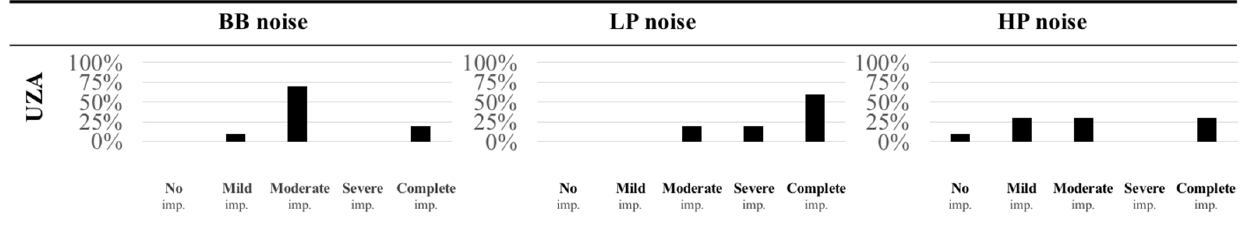
Figure 4. Application of the HEARRING_LOC_ICF scale on SSD CI data from the Antwerp University Hospital (UZA) for three different localization stimuli: BB noise, broadband noise; LP noise, low-pass noise; and HP noise, high-pass noise. Histograms are presented with the distribution of the observed localization impairment for the three different stimuli.